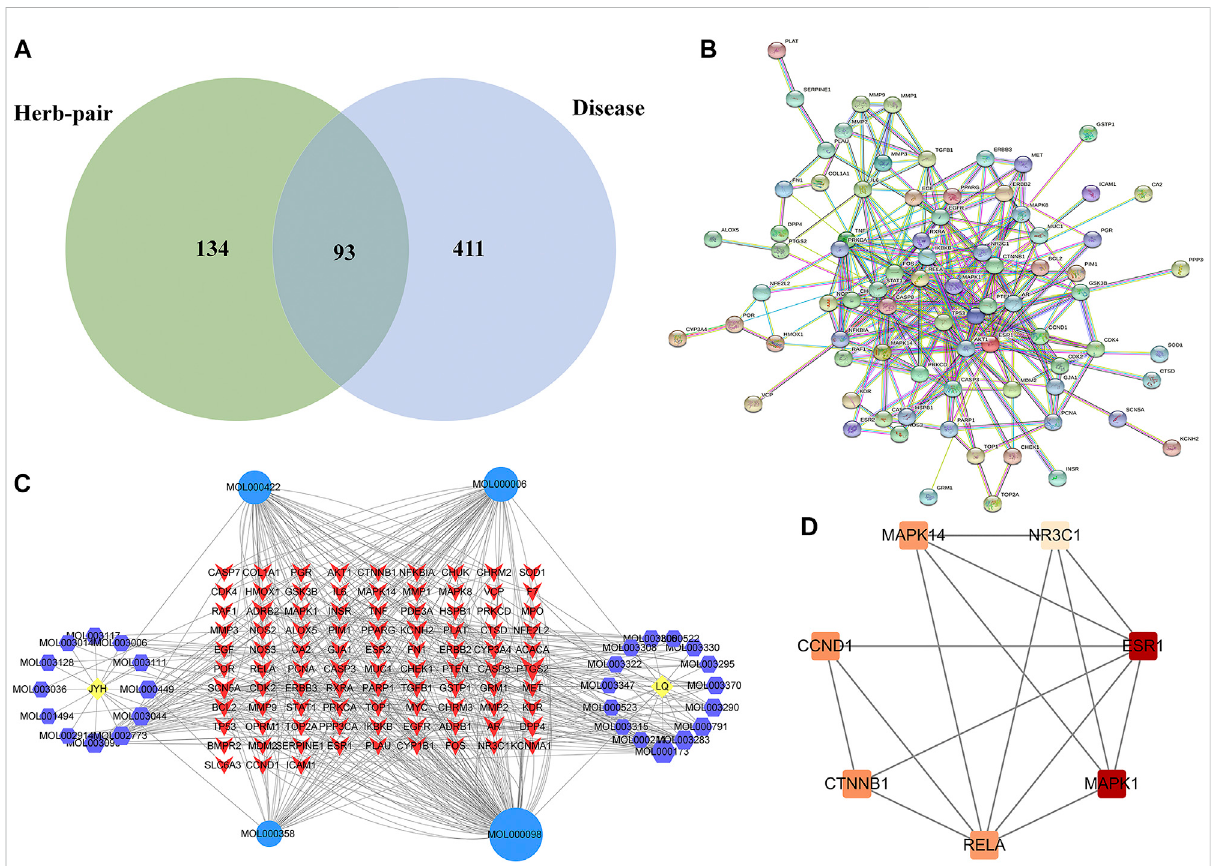
FIGURE 2 Network pharmacology analysis. (A) Venn diagram of LFP and liver fi brosis targets; (B) Composite target network of Lonicerae Japonicae Flos- Forsythiae Fructus in the treatment of liver fi brosis; (C) PPI network; (D) Key subnetwork of PPI. JYH, Lonicerae Japonicae Flos ; LQ, Forsythiae Fructus